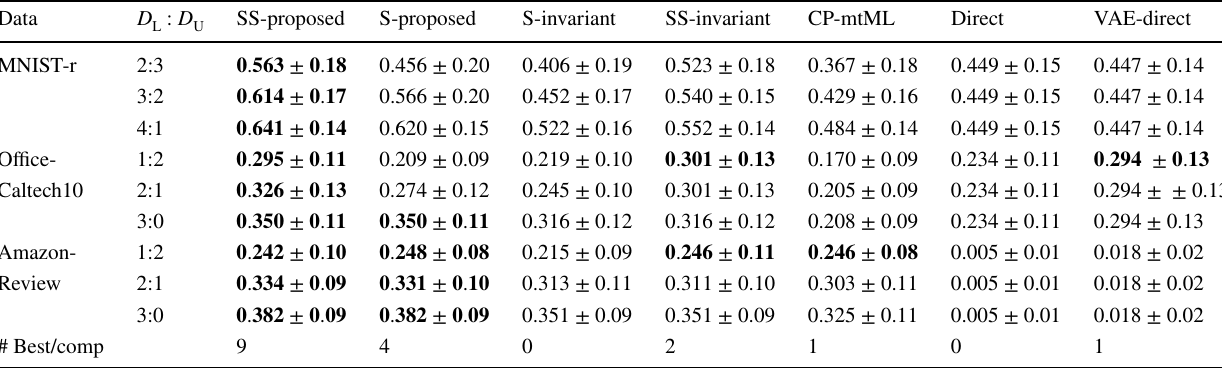
Table 1 Average and standard deviation of ARI over all unseen domains with D L labeled source domains and D U unlabeled source domains